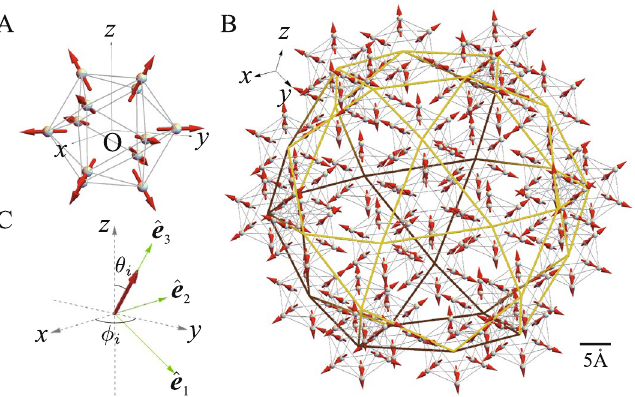
Figure 1. ( A ) The hedgehog state in the IC. Each arrow illustrates the magnetic moment at Tb, which is directed to the pseudo 5-fold axis. ( B ) The hedgehog state in Cd 5.7 Yb-type QC. Green (brown) lines at the front (back) connect the vertices of the icosidodecahedron. Scale bar (5 Å) is shown in ( B ). ( C ) Local coordinate at the Tb site with the orthogonal unit vectors